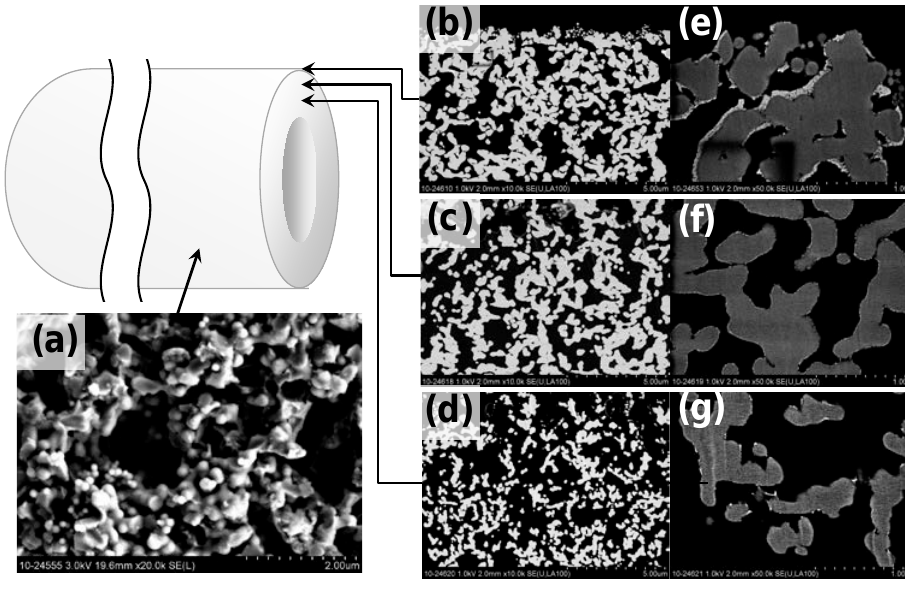
Figure 1. SEM images of the surface ( a ), secondary election images (SEIs) of the cross-section ( b – d ), and high-magnification SEIs of cross-section ( e – g ) of the TiO 2 -impregnated a-silica tube. Cross-section images were obtained at 0 ( b , e ), 0.4 ( c , f ), 0.8 ( d , g ) mm from the surface.